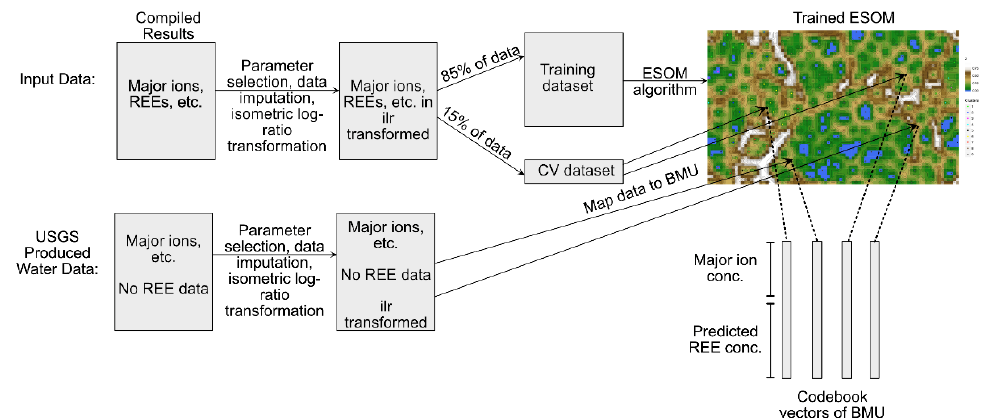
Figure 1. Flow diagram showing steps in processing and analyzing data and making REE concentra-